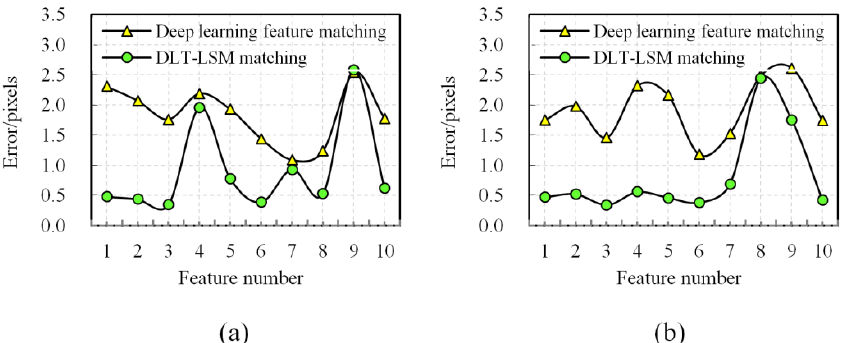
Figure 14. Contrast of the affine transform error before and after DLT-LSM for the proposed approach. For intuition, both ( a ) and ( b ) present 10 random sample features of the matching, which are respectively extracted from image pairs A and D. Table 7. Quantitative comparison of four methods based on six groups of image pairs. In this table, (cid:1866) (cid:3084) is the number of correct matches (pair), β is the correct ratio (%) of matches, (cid:2013) (cid:2902)(cid:2897)(cid:2903)(cid:2889) is the (cid:3116) matching error (pixels), MDQ is the matching distribution quality, t is the total test time (second), and η is the matching efficiency (the unit is second per pair of matching points). The best score of each index is displayed in a bold number.